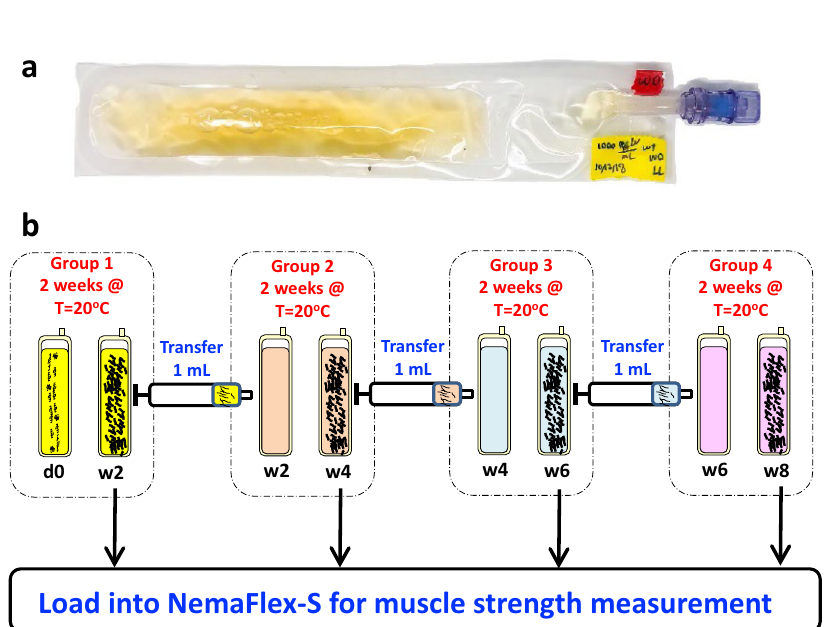
Fig. 1 C. elegans culture in CeMM and the multigenerational culture protocol. a An FEP bag containing wildtype C. elegans culture in CeMM. Image used in this fi gure was captured at TTU. b A schematic protocol for culturing C. elegans for multigenerational studies over an 8-week period. Here, d0 represents day 0 (start of the culture), and w2, w4, w6, and w8 represent week 2, week 4, week 6, and week 8, respectively.